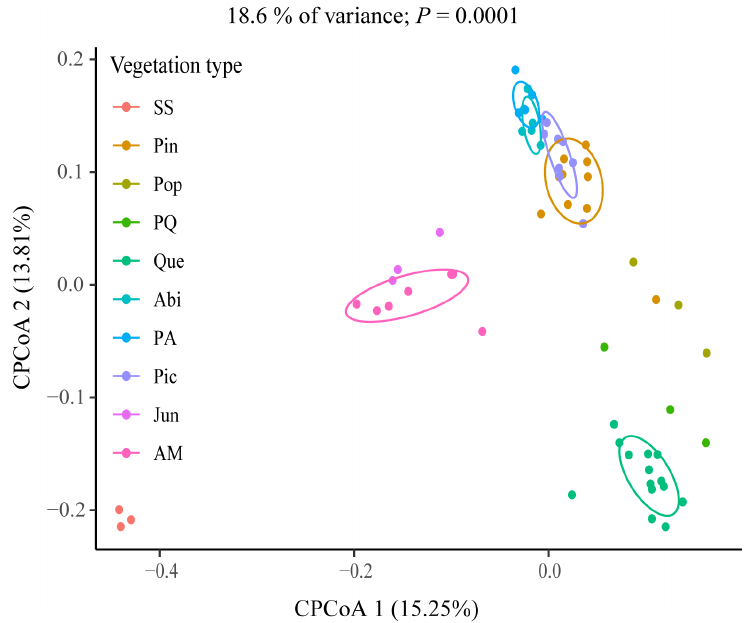
Figure 8. Constrained PCoA plot of Bray–Curtis distances constrained by vegetation type (18.6% of variance explained, p = 0.001; n = 62). Each point corresponds to a different sample with colors indicating vegetation type. The percentage of variation indicated on each axis corresponds to the proportion of the total variance explained by the projection.